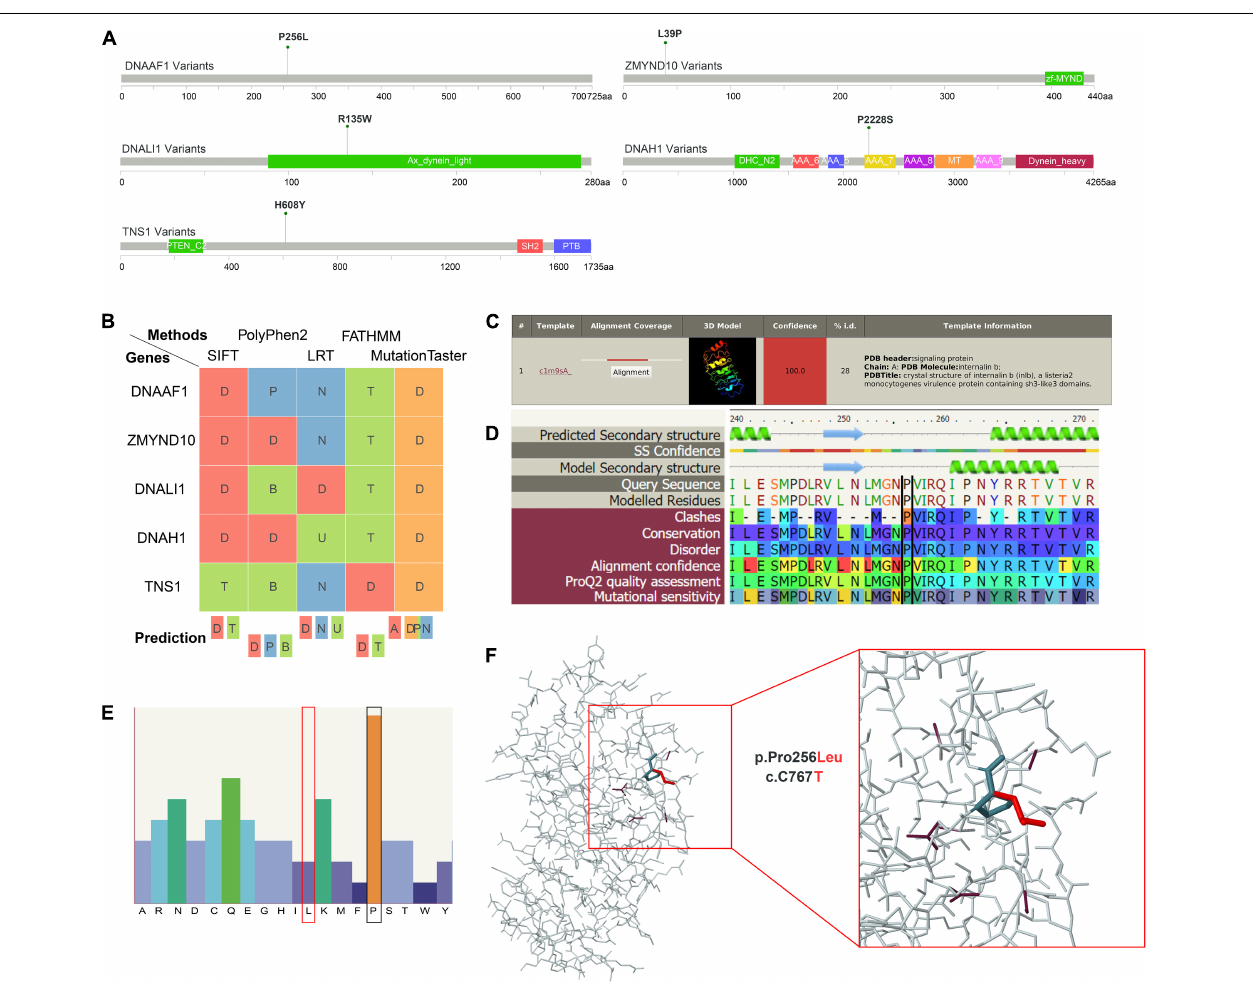
FIGURE 3 | Structural interpretation of genetic alteration in putative adolescent idiopathic scoliosis (AIS)-related genes. (A) Lollipop plot for mapping mutations on the linear protein and its domains. P256L is the significant amino acid change caused by single nucleotide variants (SNVs) on DNAAF1. (B) Deleterious prediction by in silico methods. D means deleterious in SIFT, LRT, and FATHMM. In PolyPhen2, D means probably damaging. And in MutationTaster, D means disease causing. (C) The detailed template information and models of DNAAF1. The top template was selected and analyzed in the downstream analyses. (D) The sequence view displays the predicted secondary structure of DNAAF1, the confidence in this prediction, the secondary structure of the model, the sequence, and the modeled regions. The corresponding result scores for model assessment are shown with colors. (E) The sequence profile graph of DNAAF1 represents residue preferences at a particular sequence position. (F) The predicted 3D structure of the mapping domain on DNAAF1. Wild type (dark color) and mutant type (red color) of the variant are